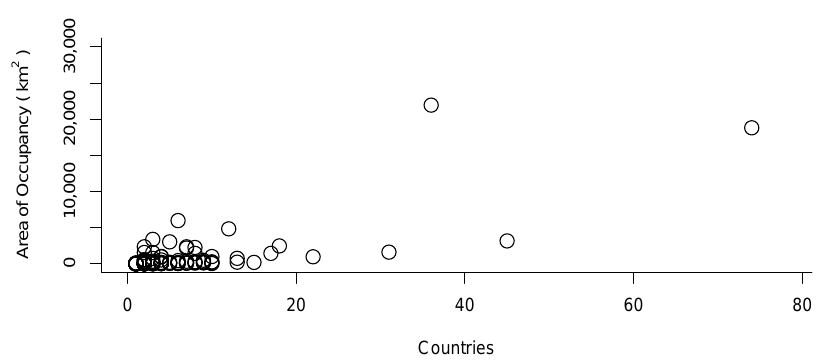
Figure 4. Relationship between area of occupancy and the number of countries that introduced parrots have been seen in the wild or are naturalized or breeding.